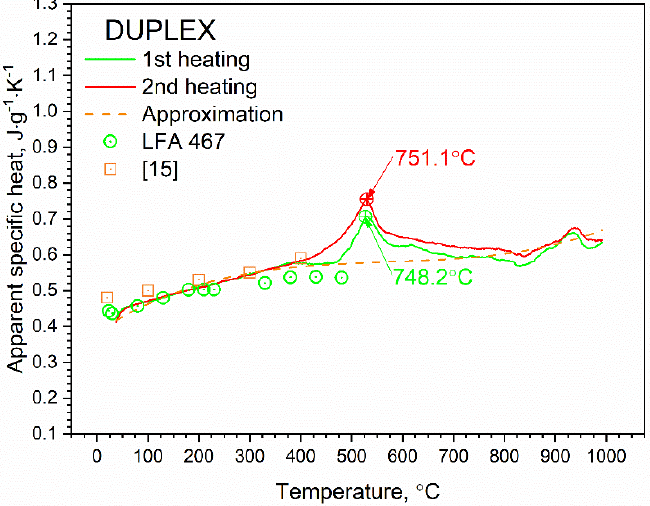
Figure 6. Results of apparent specific heat for duplex steel (own measurements vs. literature data).